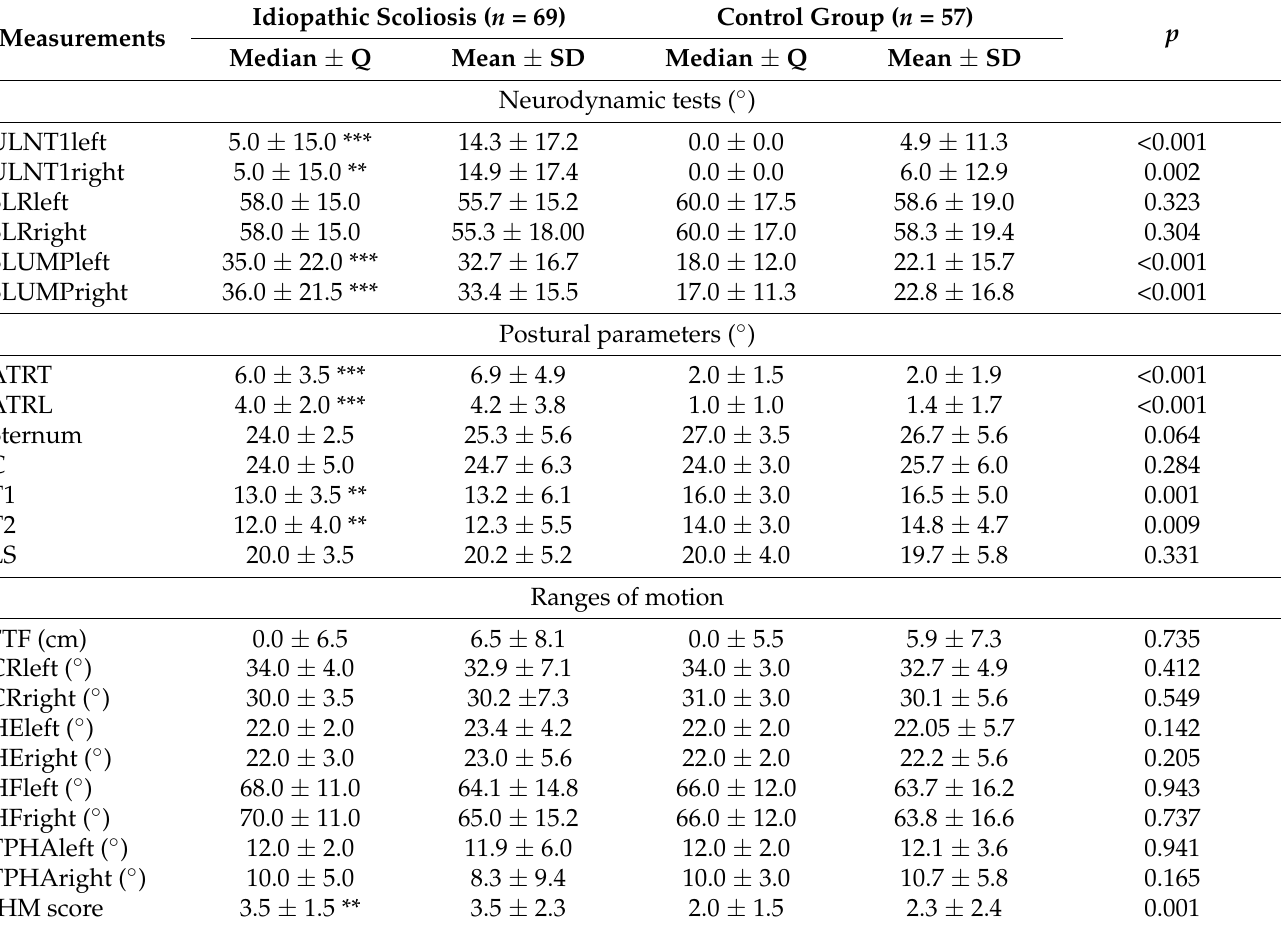
Table 2. The values of neurodynamic tests, postural parameters and ranges of motion in adolescents with idiopathic scoliosis (IS) and the control group